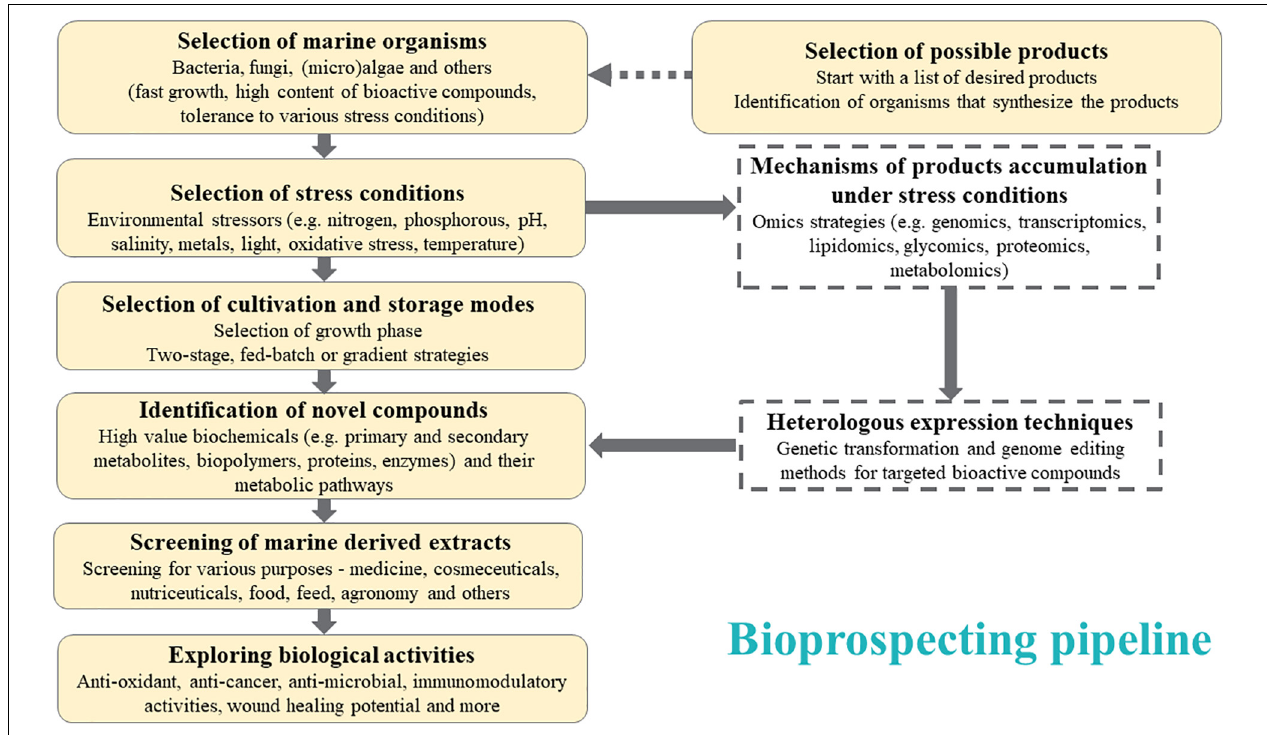
FIGURE 1 | Schematic representation of a bioprospecting protocol for the extraction of valuable bioactive compounds from marine organisms (adapted from Chen et al.,